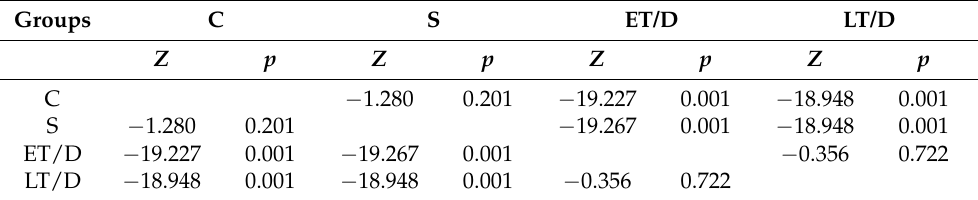
Table 3. Binary comparison results of the groups for TAA/TNA ratio.